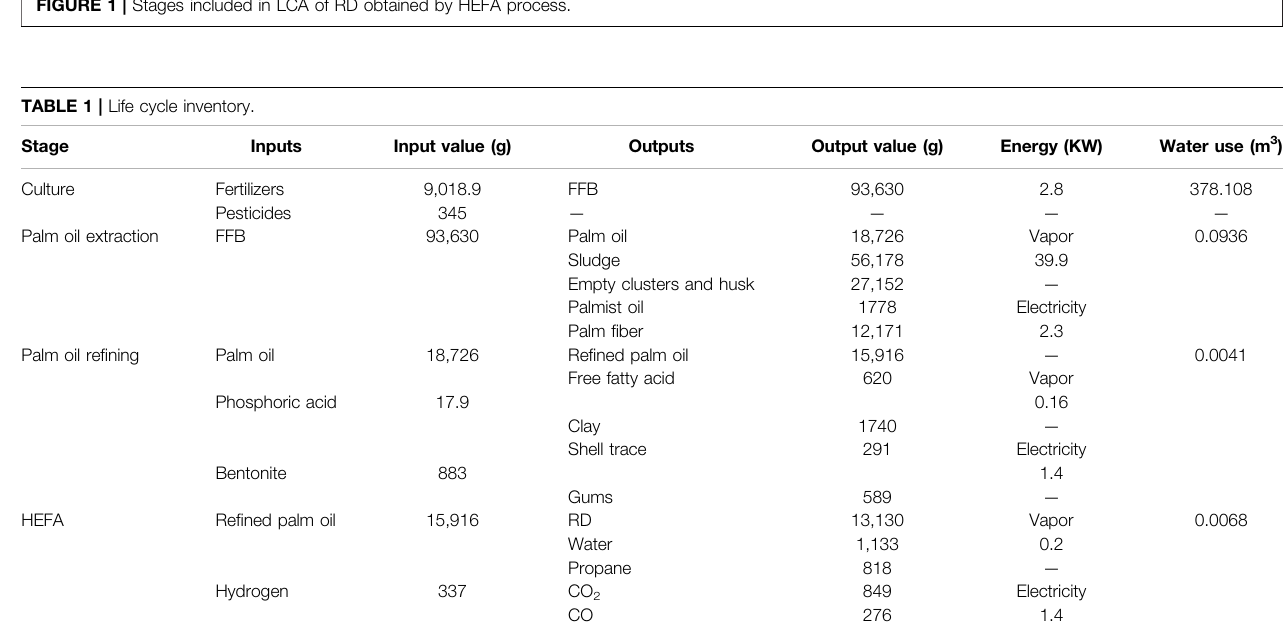
FIGURE 1 | Stages included in LCA of RD obtained by HEFA process.